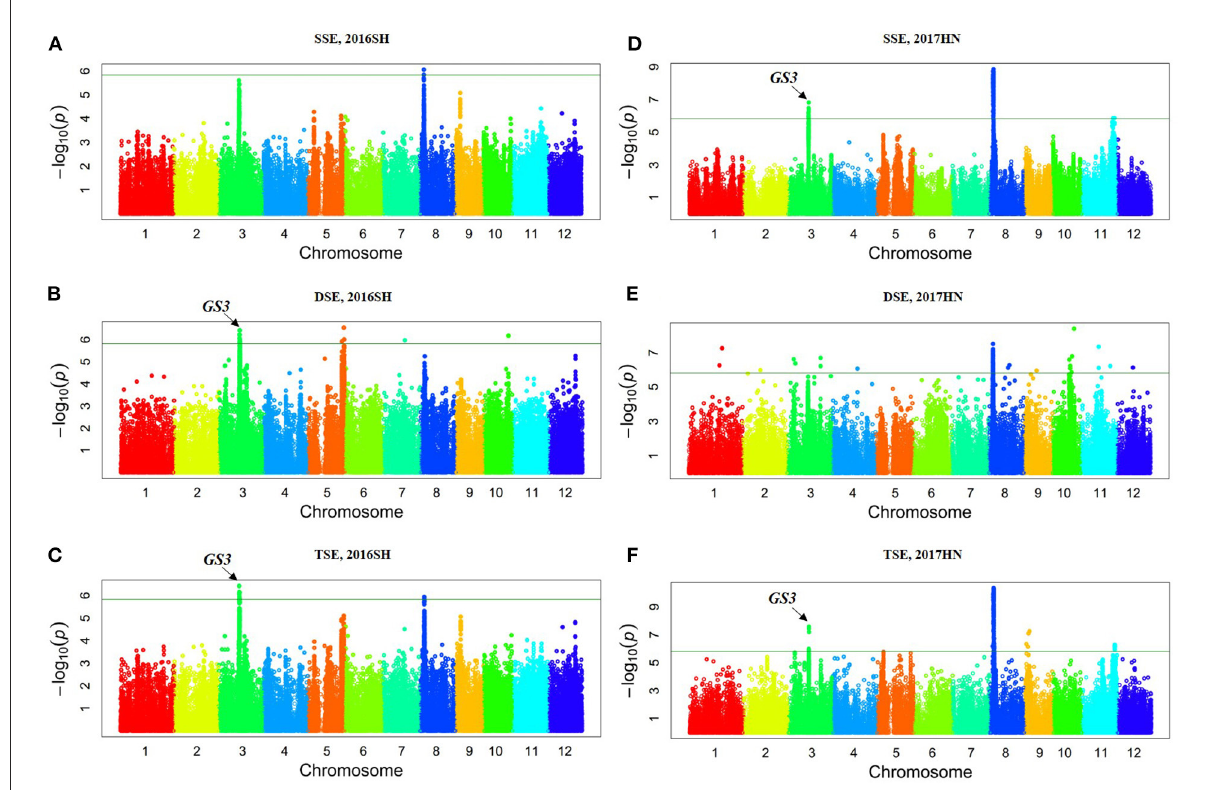
FIGURE1 Manhattan plots of genome-wide association mapping for the stigma exsertion rate in Collection 2. 2016SH: 2016 Shanghai (A–C) ; 2017HN: 2017 Hainan (D–F) ; TSE, total stigma exsertion rate; SSE, single stigma exsertion rate; DSE, dual stigma exsertion